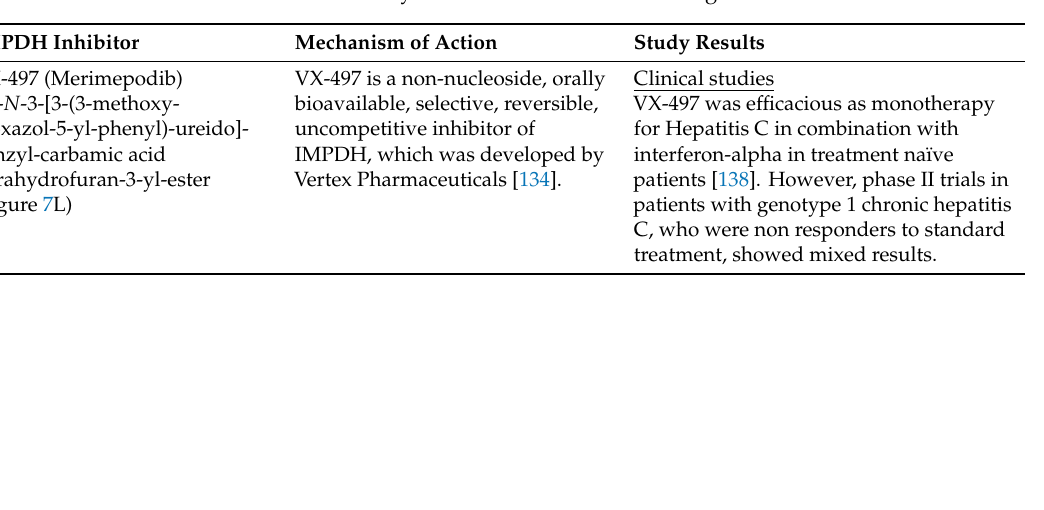
Table 4. Summary of VX-497 as an anti-viral